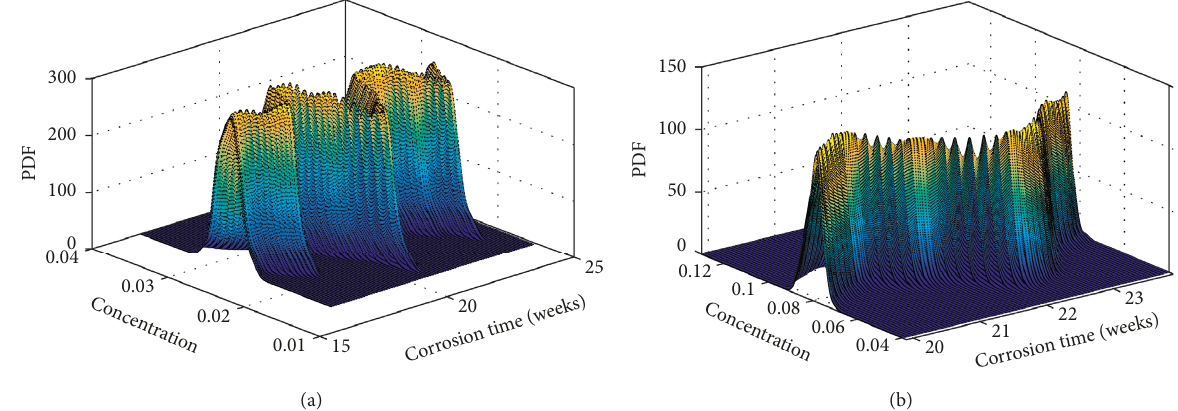
Figure 10: PDF surface of the concentrations of (a) gypsum and (b) ettringite.